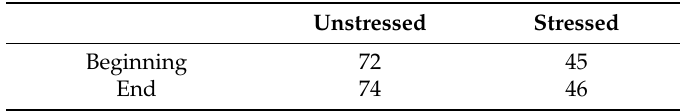
Table A5. Token counts for vowel formant measurements used to visualize vowel space and calculate vowel space area for Informant B in Section 4.2.2.